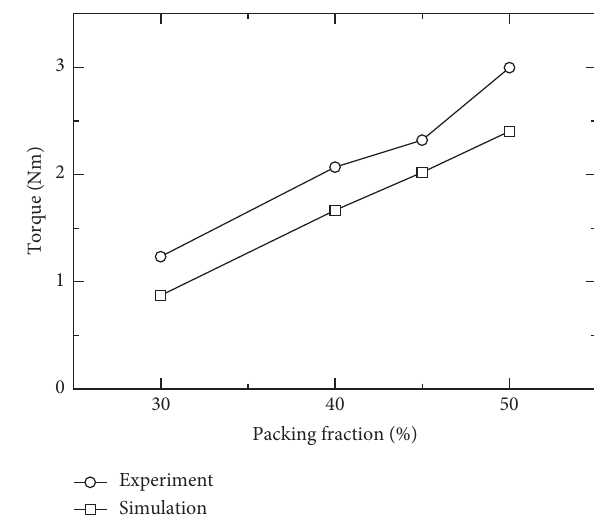
Figure 5: Time history of the rotary damper with a no-gap model using 3 mm diameter particles; the packing fraction is 50%, and the rotational speed is 60rpm.